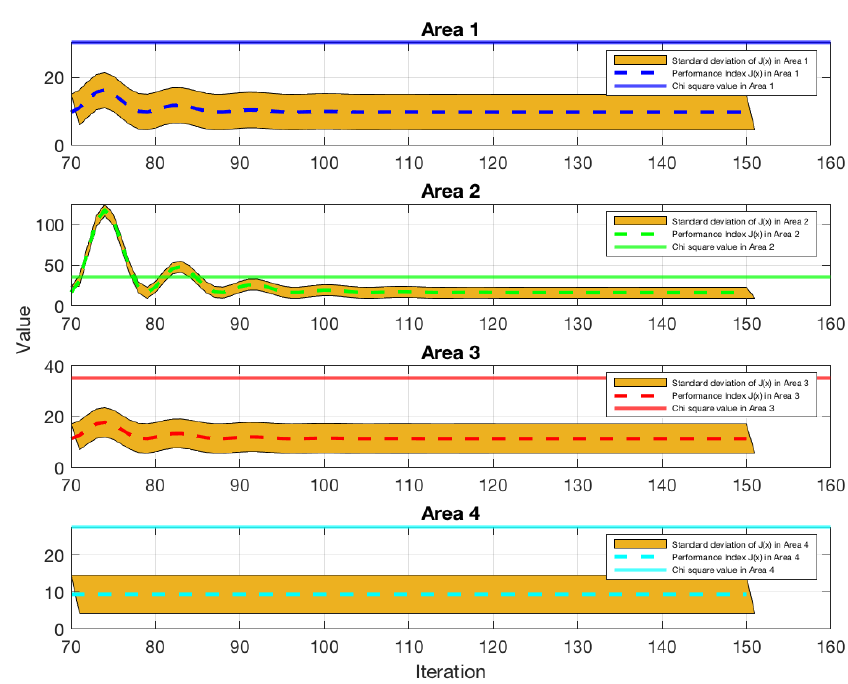
Figure 6. Per area mean of J(x) on the IEEE -14 bus system 4 regions with standard